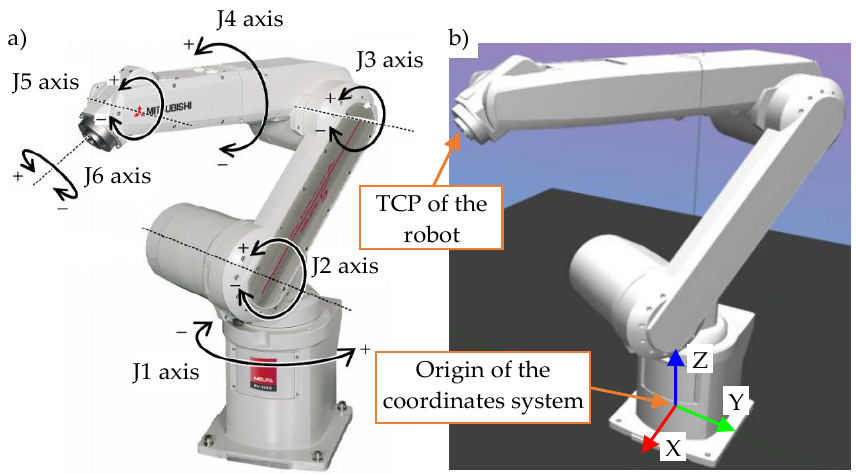
Figure 2. The Mitsubishi RV-12SDL-12S used in the research: ( a ) the physical robot with marked joints; ( b ) the 3D model of the robot in a virtual environment with marked axes X, Y, and Z.